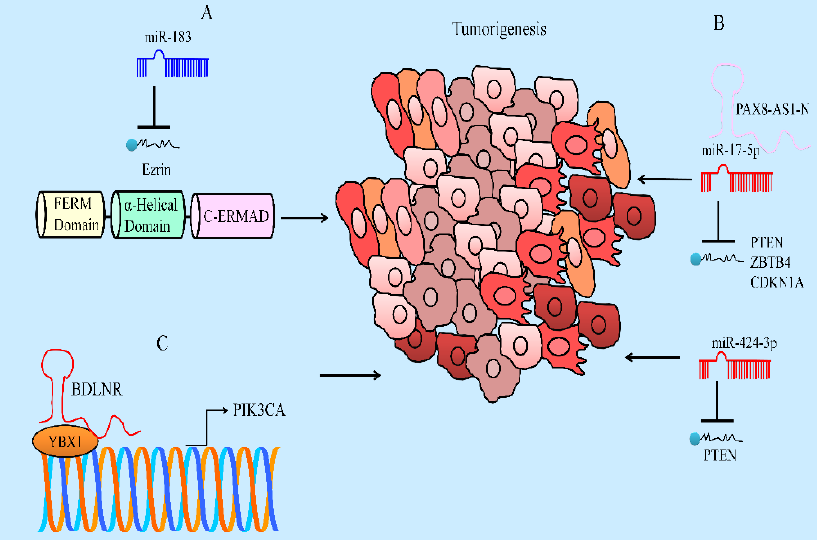
Figure 4. (A) Ezrin is a target gene of tumor suppressor miR-183. miR-183 inhibited tumorigenesis but ezrin promoted tumorigenesis. (B) miR-17-5p and miR-424-3p are oncogenic miRNAs. These miRNAs targeted PTEN. Tumor suppressor lncRNA blocked miR-17-5p-mediated targeting of PTEN and inhibited carcinogenesis. (C) BDLNR physically associated with YBX1 and promoted its binding to PIK3CA promoter and facilitated cancer progression.